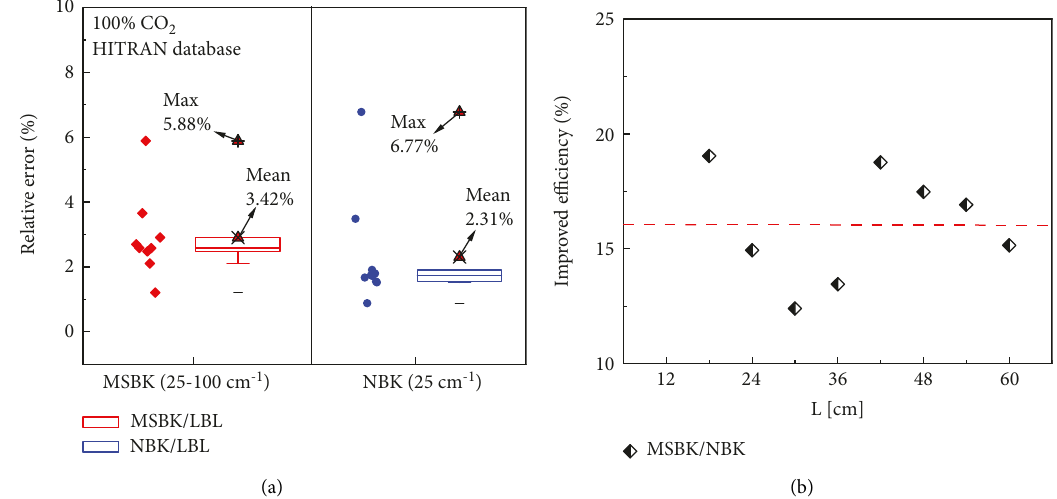
Figure 7: Accuracy and efficiency of MSBK model in a nonisothermal